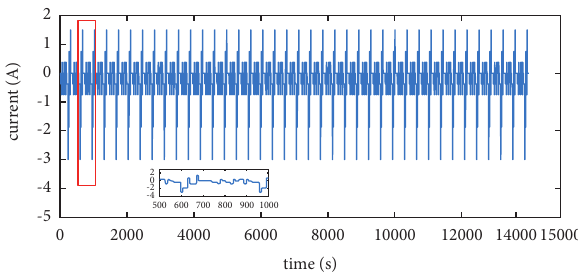
Figure 12: Dynamic stress test (DST)